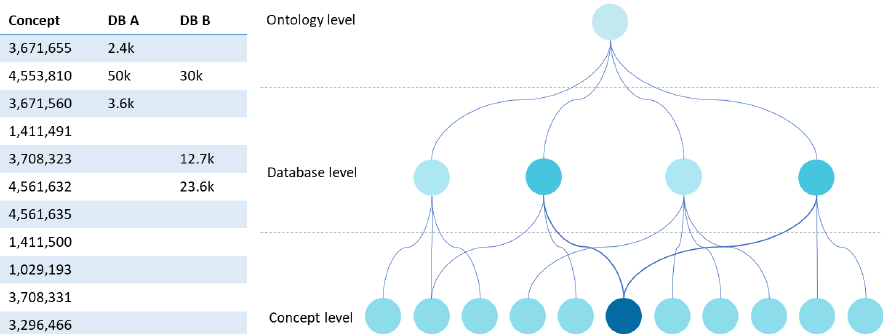
Figure 5. UI mockup proposal of a dendrogram